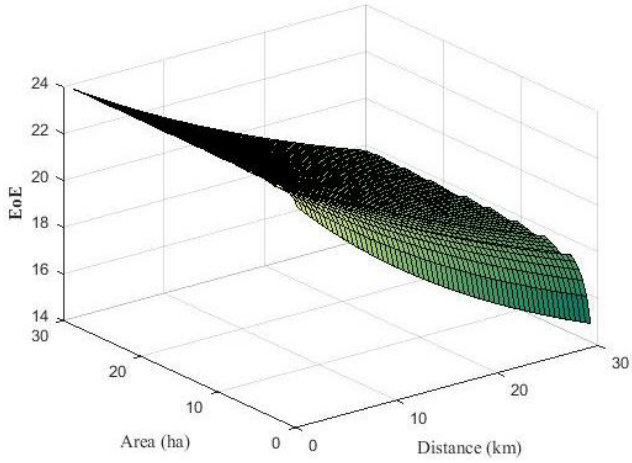
Figure 9. Efficiency of energy (EoE) surface for various field-to-storage distances and field areas.